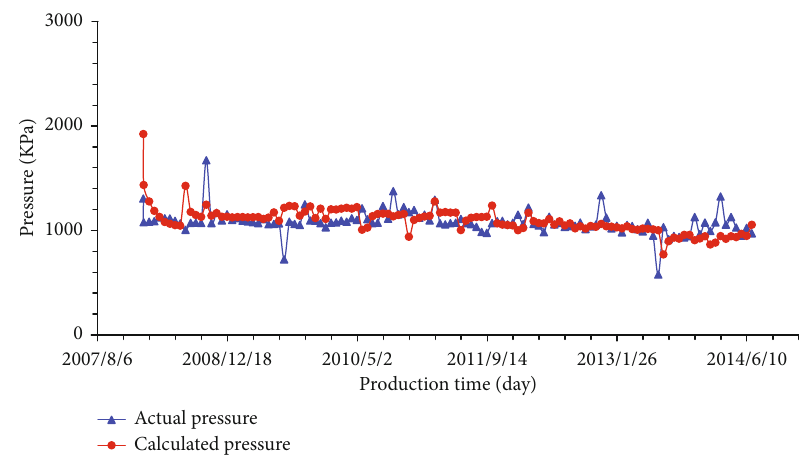
Figure 9: Fitting of production and cumulative production in a single well.